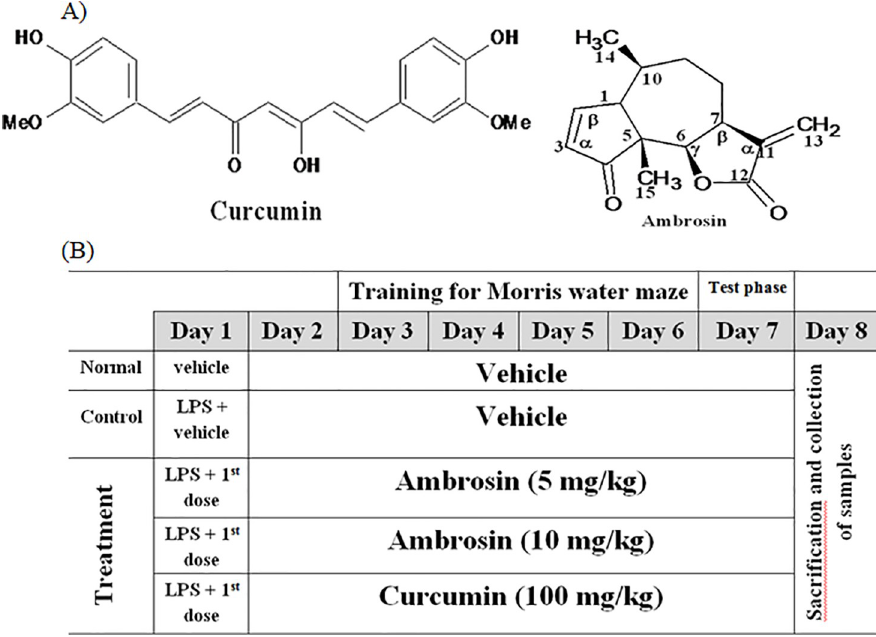
Fig 1. Chemical structures of Curcumin and Ambrosin (A) and diagrammatic table of the experimental design (B).